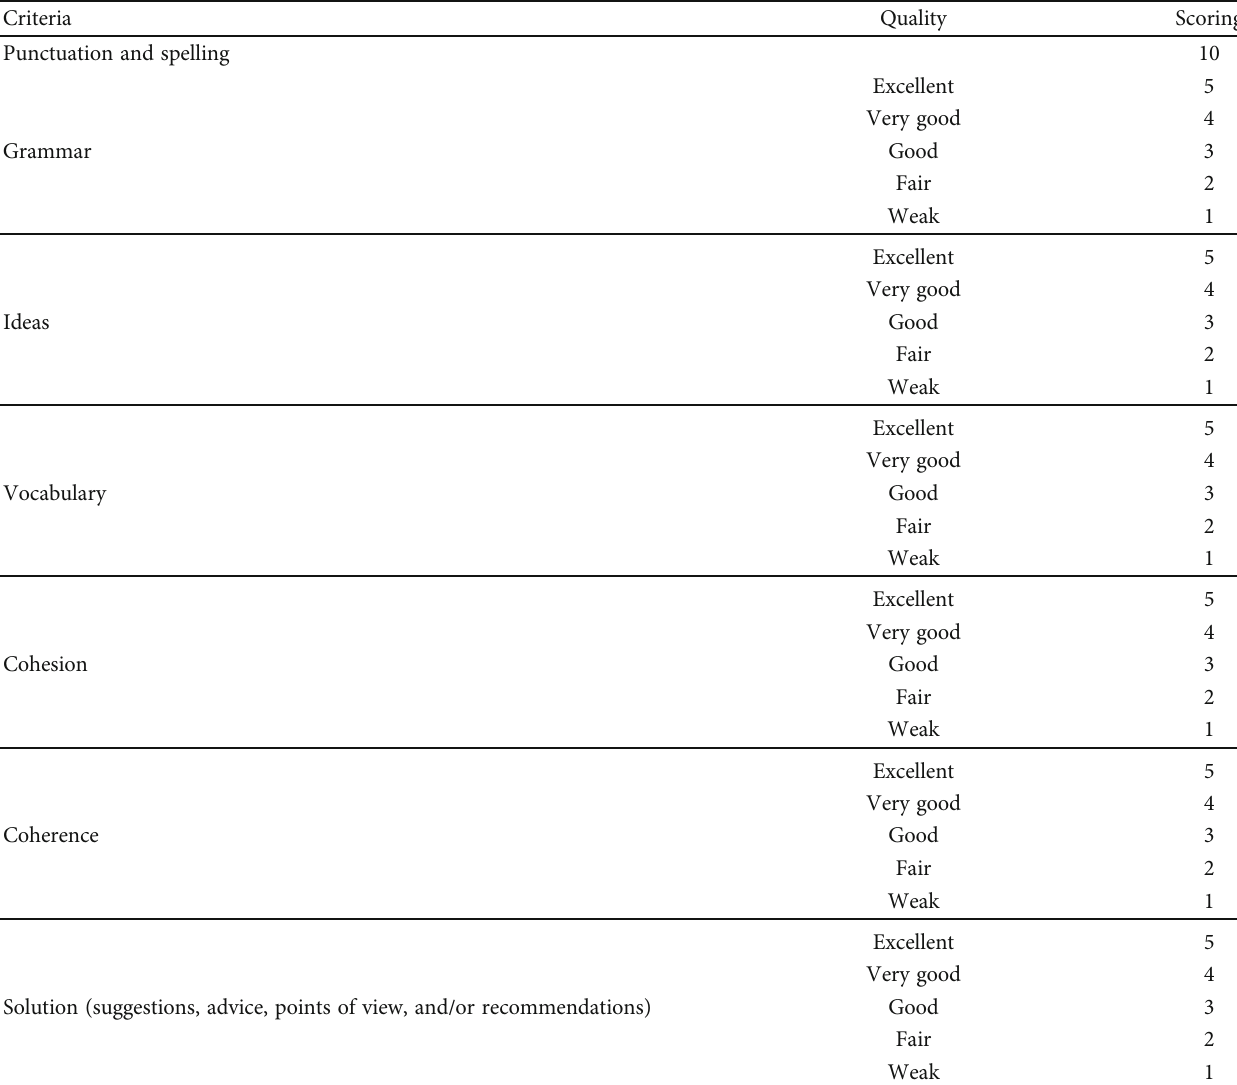
Table 2: Scoring scheme of the posttest.